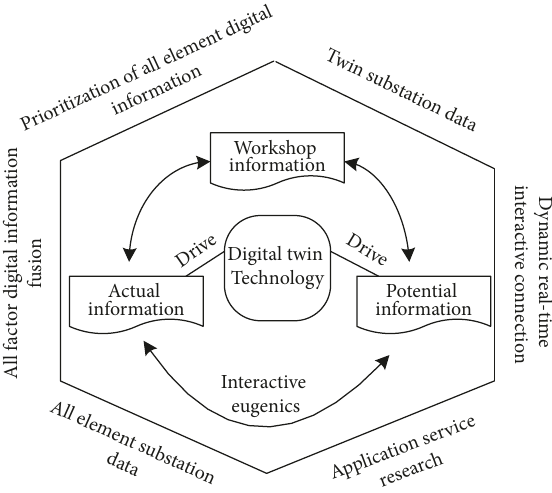
Figure 3: Multidimensional control of digital twin technology with the all-factor digital information of the flexible industrial